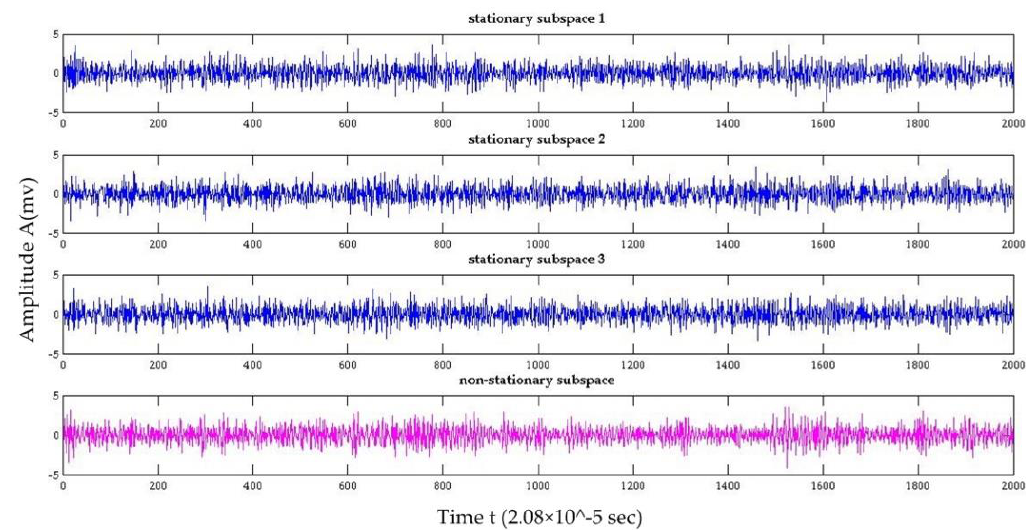
Figure 7. SSA results of severe wear tool sample.